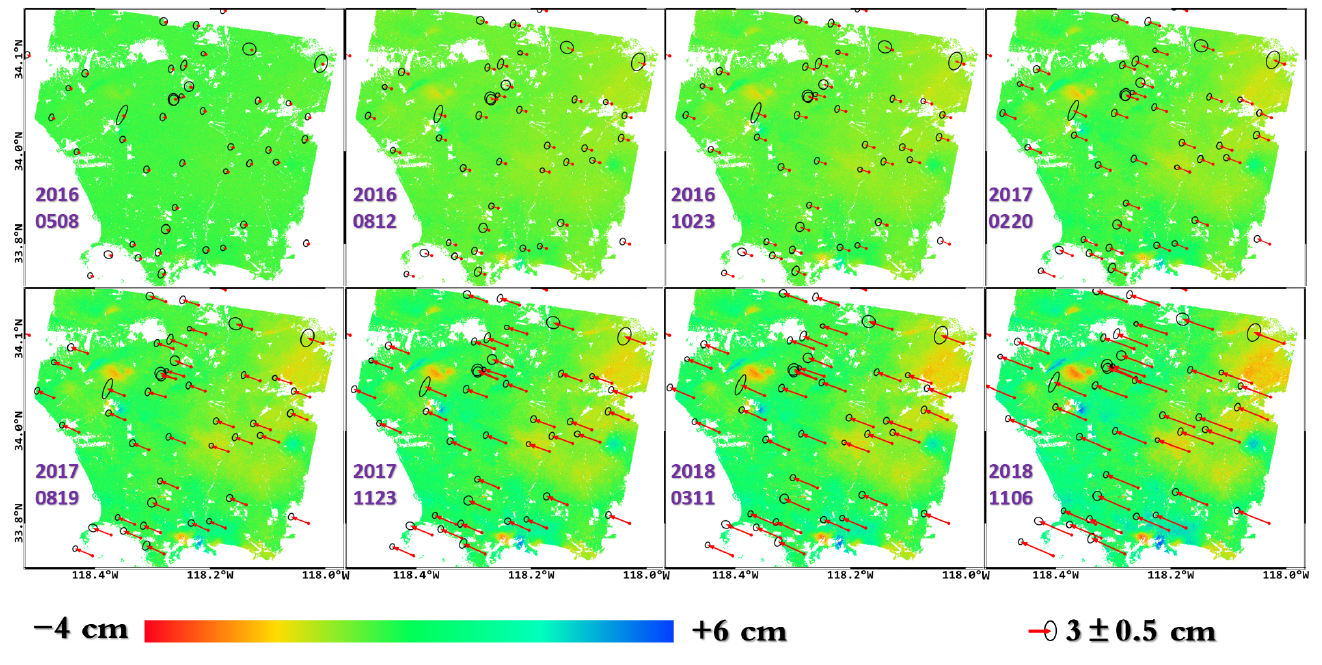
Figure 6. Deformation time series maps of ascending InSAR. GNSS sites with displacement vectors are indicated by red arrows. The black ellipses represent the horizontal errors.